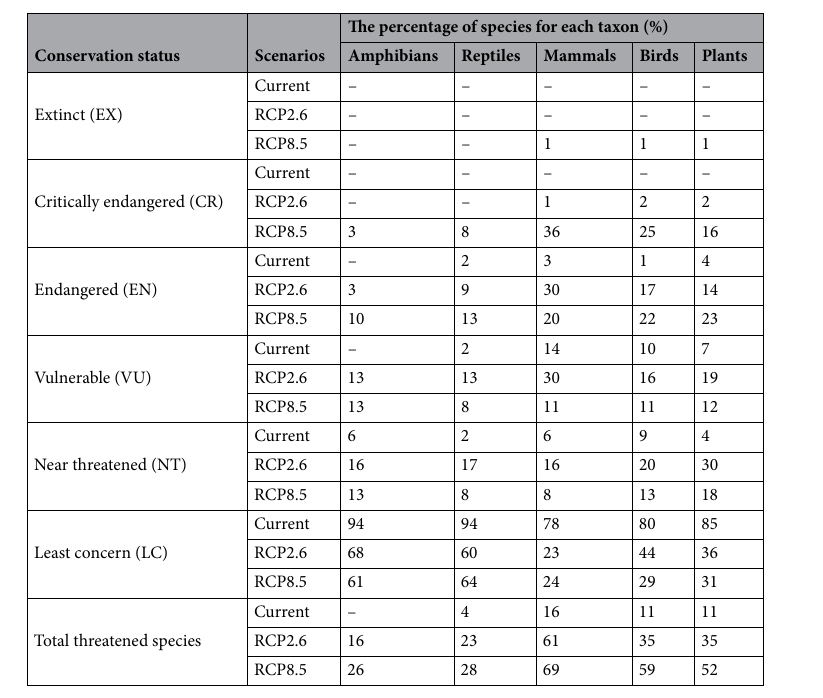
Table 4. Current and projected 2070 conservation statuses of the modeled